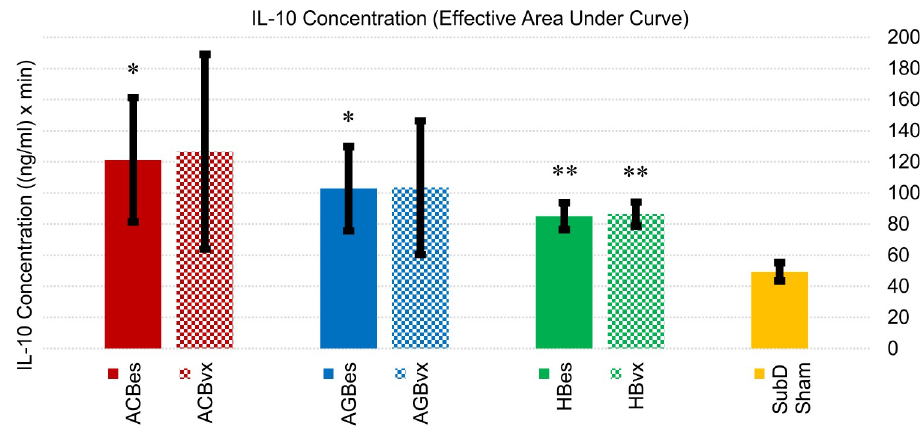
Fig 7. Cumulative IL-10 concentration effects of subgroup responses to IP injection of LPS (5 mg/kg). Values represent effective areas under the curve for each subgroup shown in Fig 6. Error bars, s.e.m. � p < 0.05 compared to SubD Sham group. �� p < 0.01 compared to SubD Sham group.